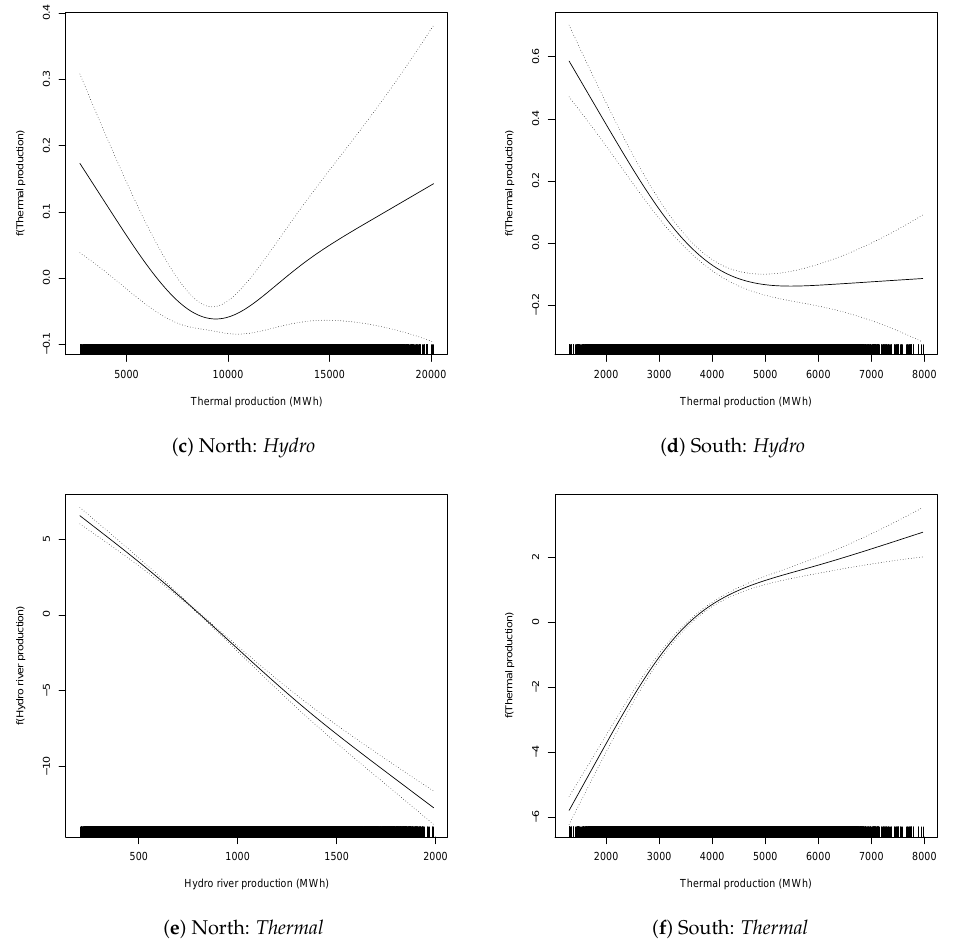
Figure 7. in-sample estimation results of the non-parametric additive model for the conditional variance of electricity prices. For both zones, each panel plots the estimated function h j ( · ) for the renewable energy production